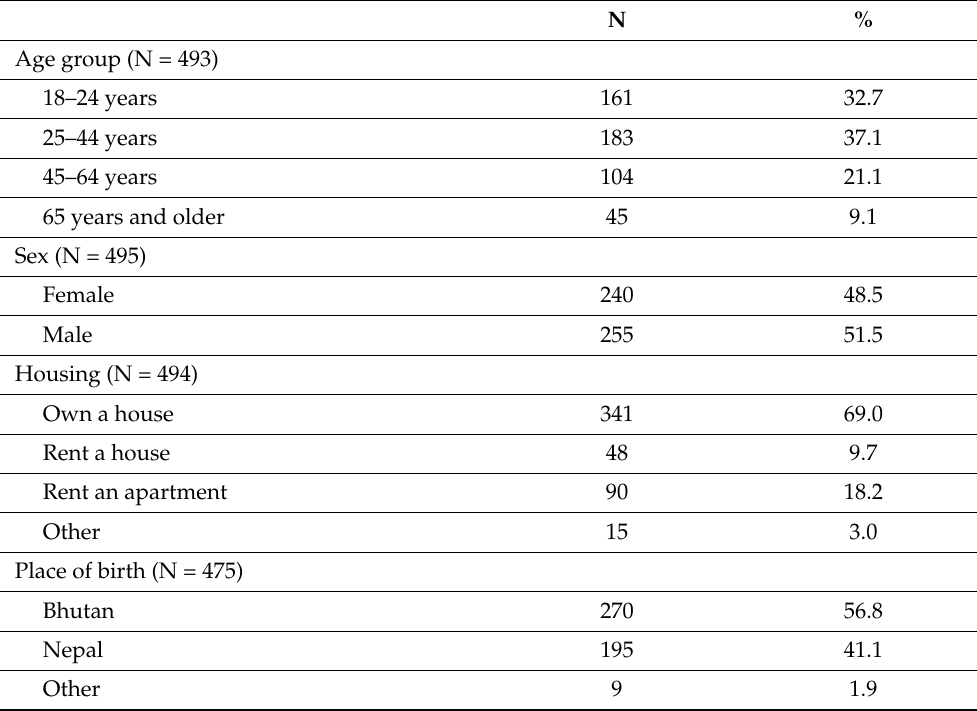
Table 1. Sociodemographic characteristics of the central Ohio Bhutanese community.